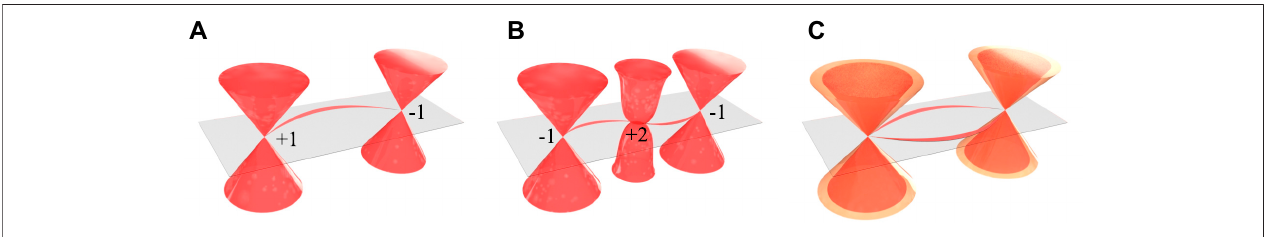
FIGURE 1 | (A) Pair of charge-1 Weyl points linked by a Fermi arc in the momentum space. The Weyl points have a cone-like linear dispersion. On equifrequency contour(grayplane),thesurfacestatesformanopenarclinkingtheprojectionofWeylpoints. (B) Charge-2Weylpoint (middle) linkedwithtwocharge-1Weylpoints. (C) A pair of 3D Dirac points as Z 2 monopoles linked by two branches of Fermi